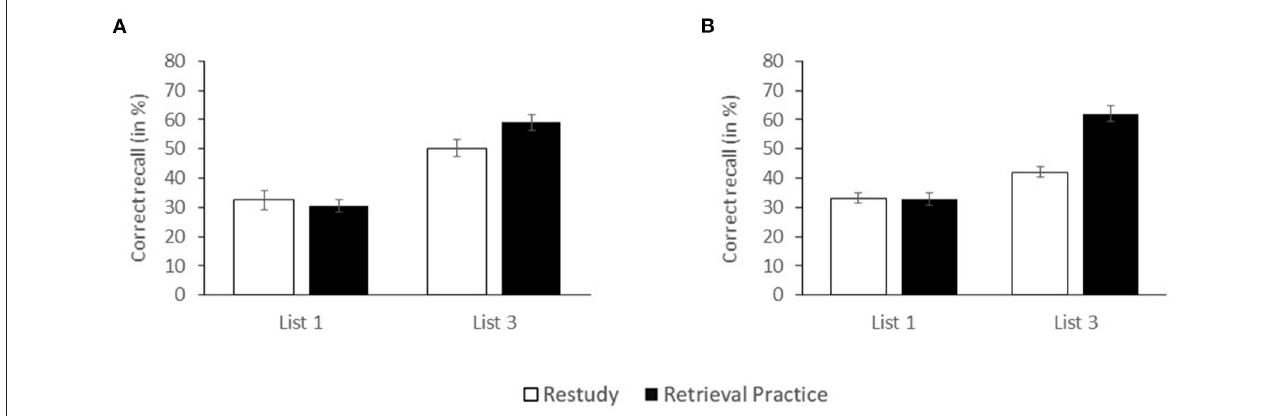
FIGURE 1 | Recall rates of first-list and last-list (list 3) items as a function of PRACTICE for (A) unrelated study lists (Experiment 1a) and (B) categorized study lists (Experiment 1b). Error bars reflect standard